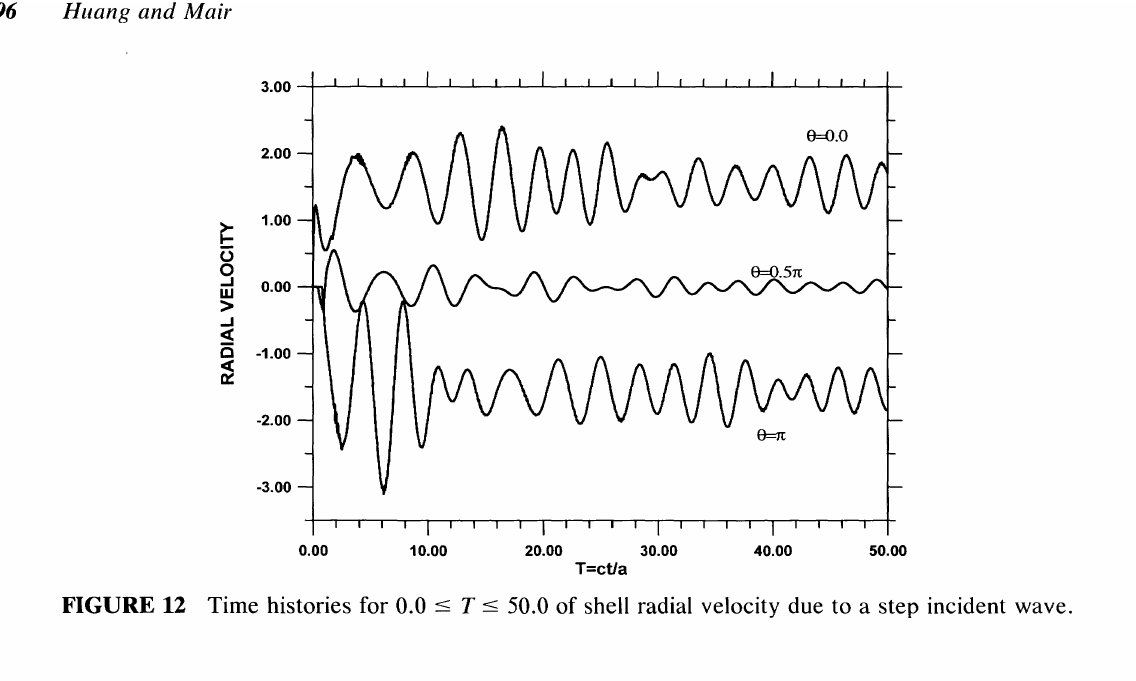
FIGURE 12 Time histories for 0.0 :s T:s 50.0 of shell radial velocity due to a step incident